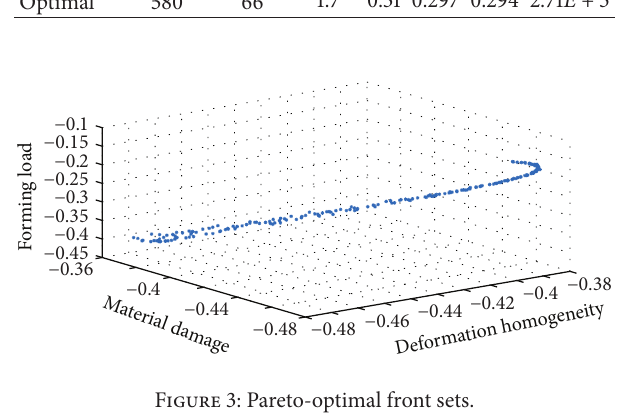
Figure 3: Pareto-optimal front sets.